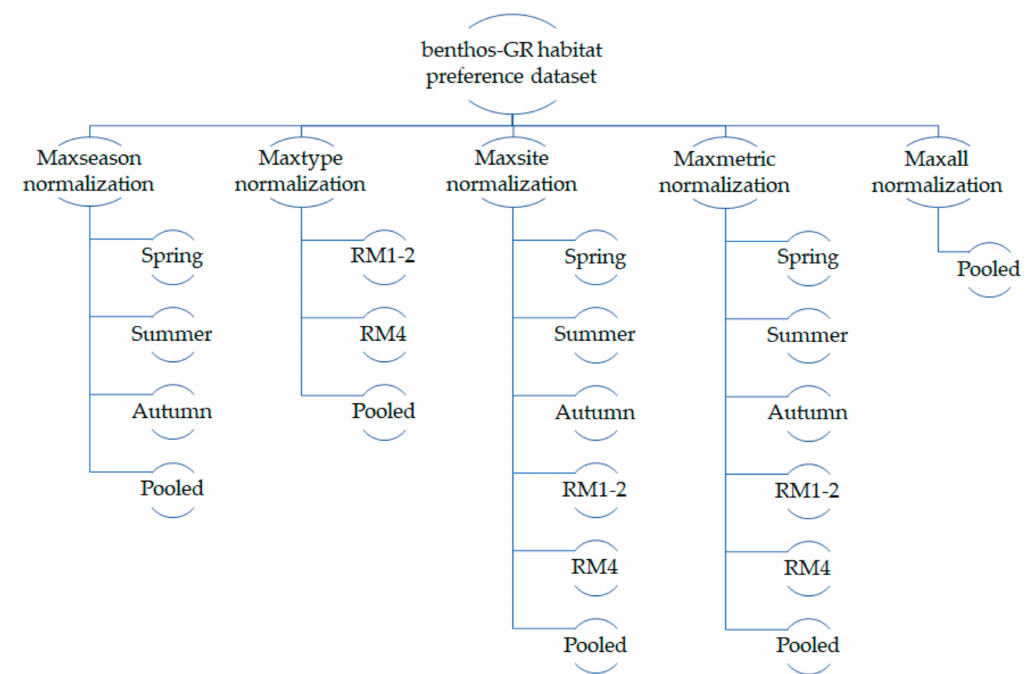
Figure 3. Seasonal and typological subsets of the benthos-GR dataset developed within the various κ -normalization methods. In total, 20 subsets were developed and 20 environmental flow assessments were applied at each test case, using each subset as a training dataset for the habitat